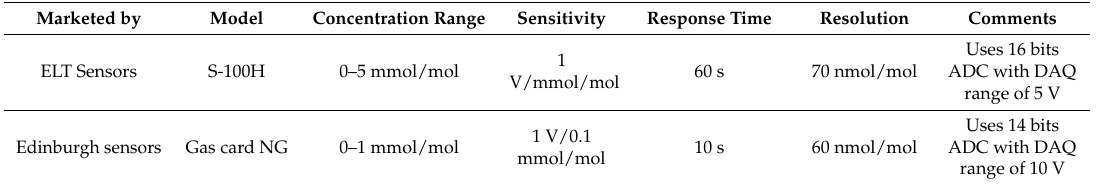
Table 2. Commercialized carbon dioxide sensors for field experiments.